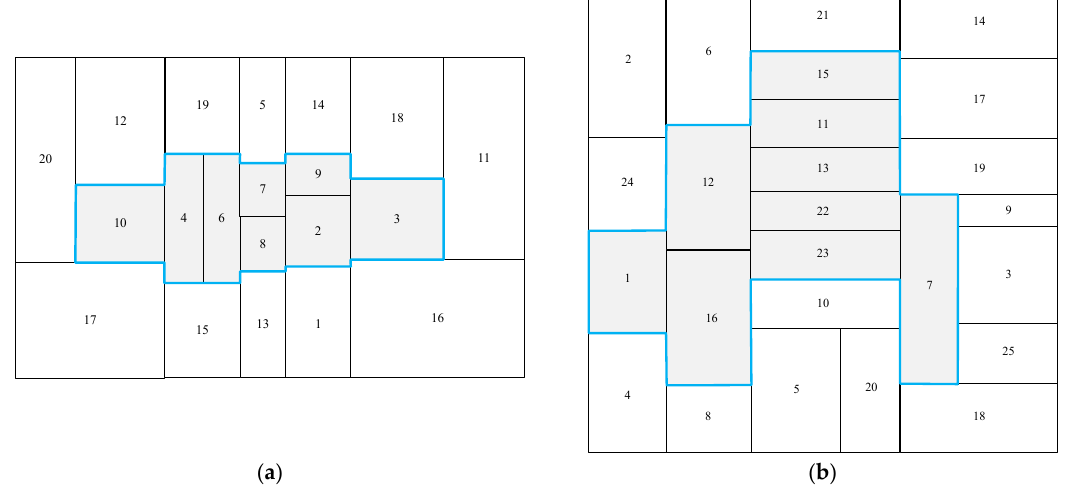
Figure 14. Layout configurations. ( a ) AB20; ( b ) KC25. Mathematics 2019 , 7 , x FOR PEER REVIEW